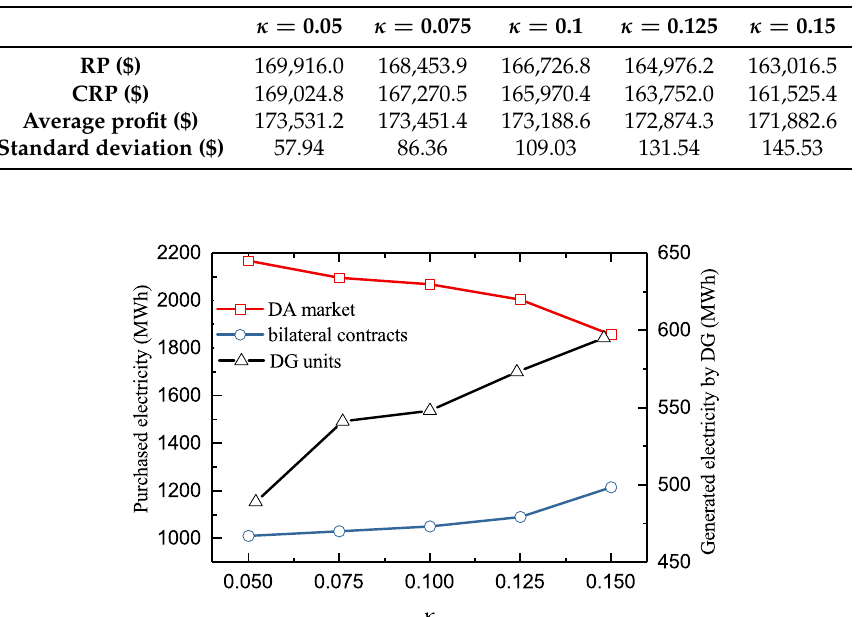
Table 5. RP, CRP, average profit and standard deviation under different κ .